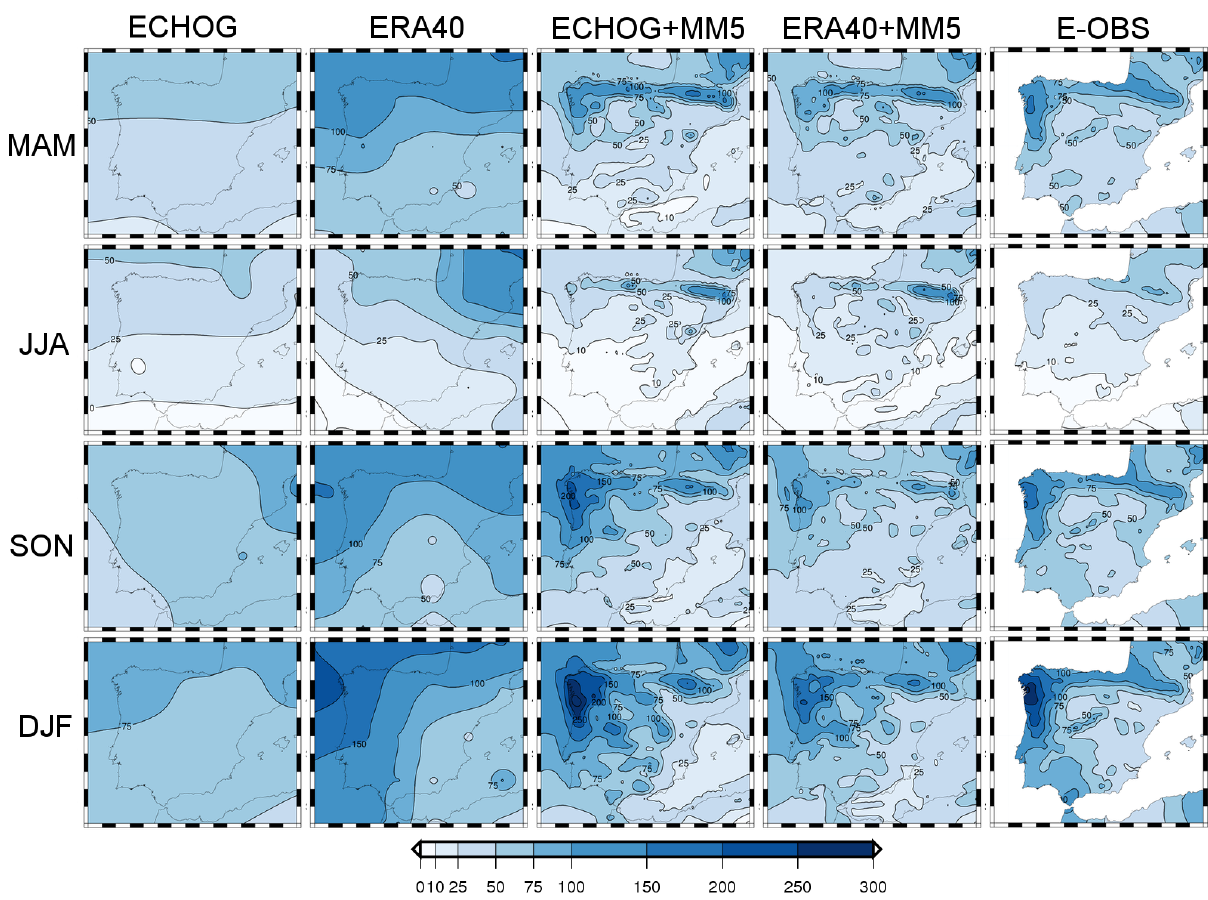
Fig. 4. Mean value of monthly precipitation (in mm/month) in the period 1961-1990 for ECHO-G, ERA40, and MM5 nested to both (by columns) in all the seasons (by rows). Last column depicts the values for the E-OBS data base. All fields have been interpolated onto a 7-minute regular grid to ease the visual comparison.